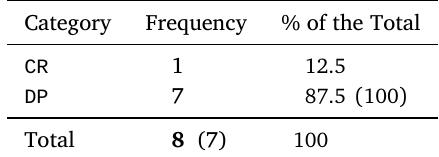
Frequency of query – query response categories (AMEX) (The parenthesized percentage is the percentage recalculated once the CRs are excluded from the sample.)